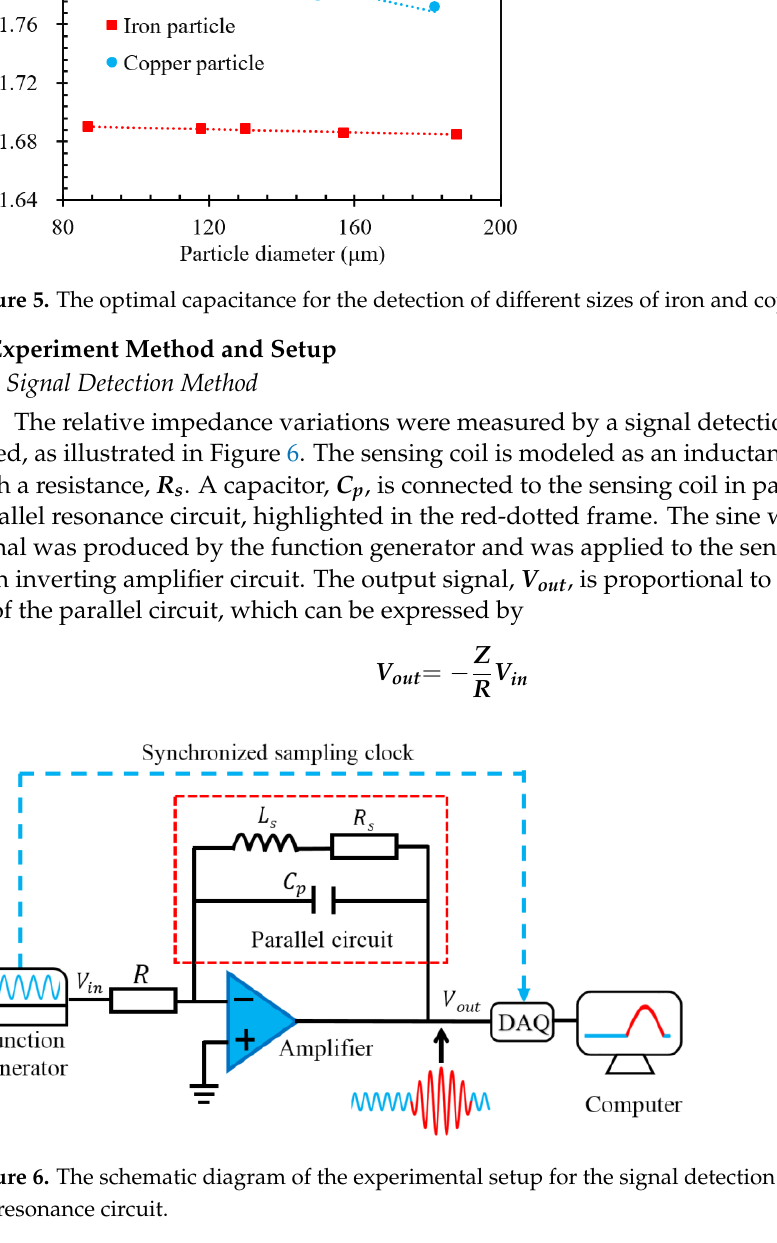
Figure 5. The optimal capacitance for the detection of different sizes of iron and copper particles.